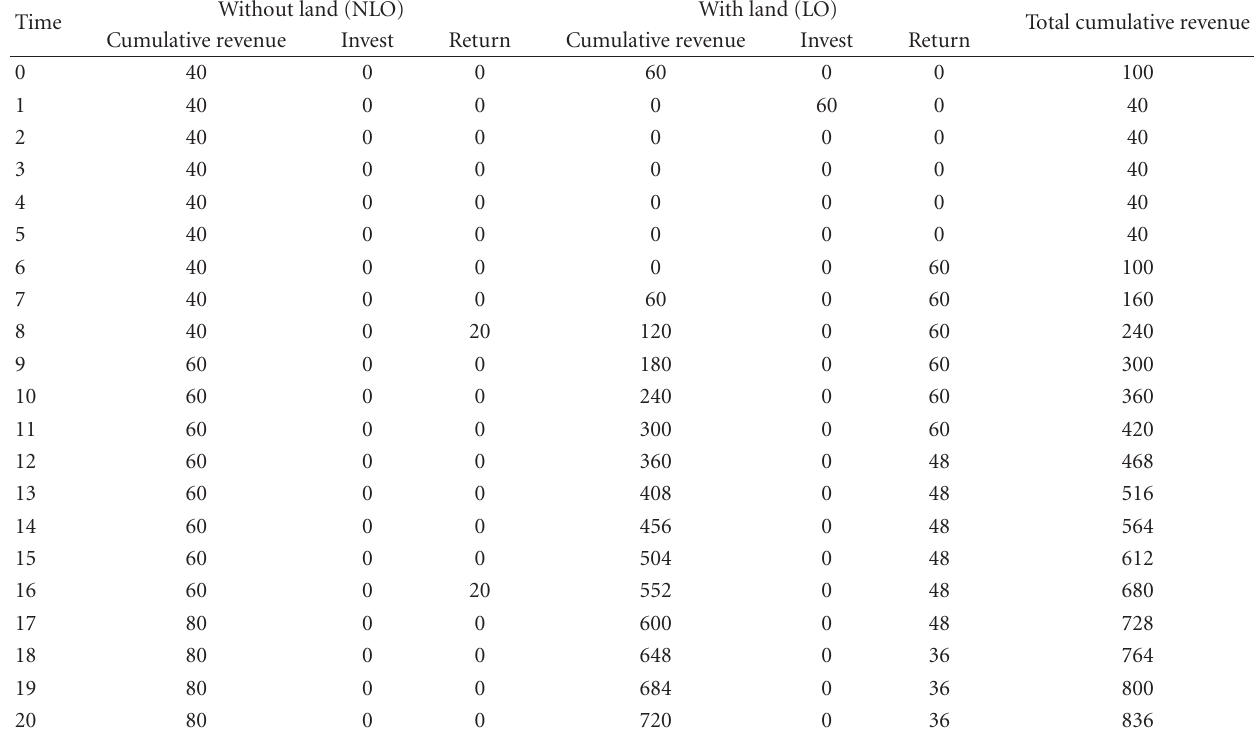
Table 3: Scenario B: the players’ cumulative revenue under scenario B (million